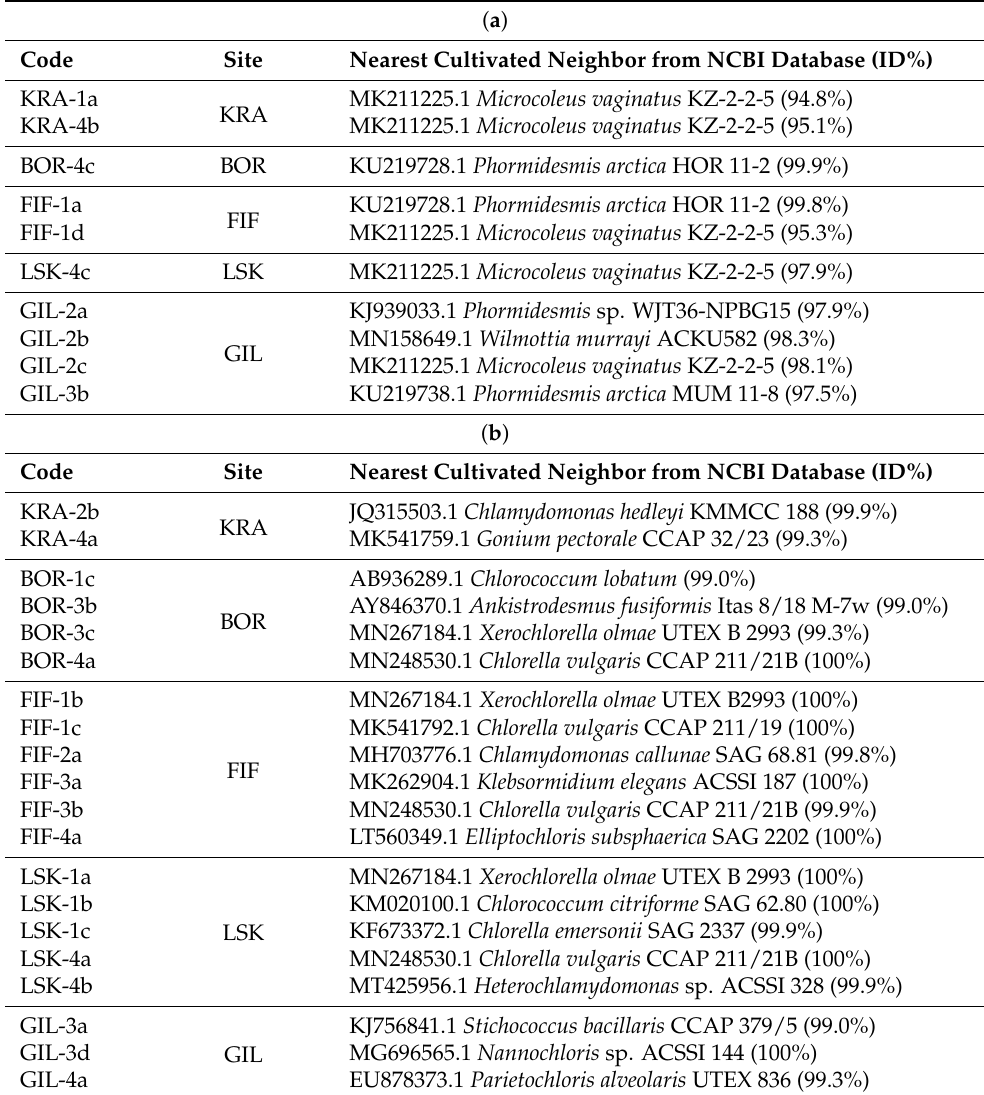
Table 1. Cyanobacteria ( a ) and eukaryotic microalgae ( b ) isolated from the localities and their most closely related isolates retrieved from the NCBI database. ( a